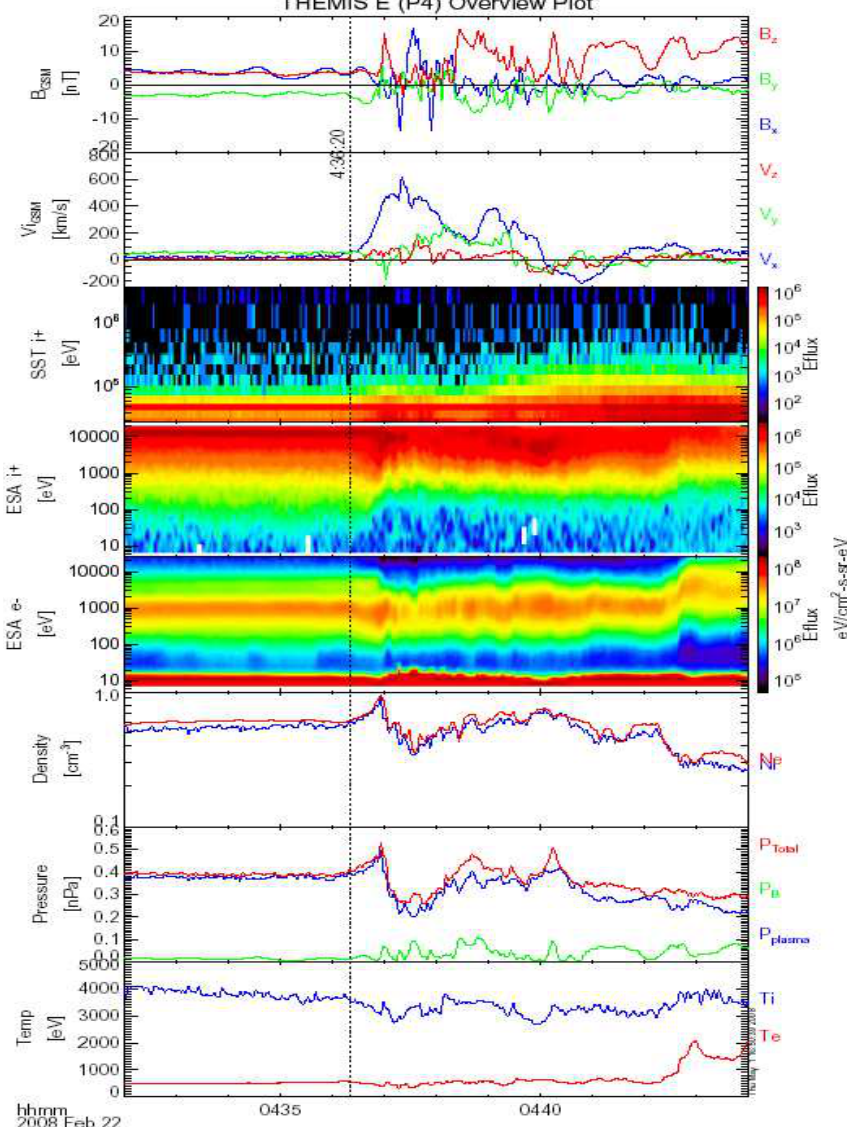
Fig. 7. Observations of THE on 22 February 2008 around 04:35UT. The recovered electric field consists of two successive pulses with total duration of ∼ 6 min. The amplitude of the first pulse is ∼ 0.65 mV/m, of the second one ∼ 1.1 mV/m (Fig. 9). These dimensional results were obtained with the velocity normalization unit v = 290 km/s. Use of smaller propaga- tion velocity v = 240 km/s reduces electric field amplitude for ∼ 0.15 mV/m and shifts the X-line tailward for ∼ 1 R E . On the contrary, use of greater values for propagation veloc- ity v = 330 km/s and v = 440 km/s shifts the X-line towards the Earth to positions ∼ − 17 . 8 R E and ∼ − 15 . 7 R E , corre- spondingly. The last position is unrealistic, since it is situated Earthward of THC probe.